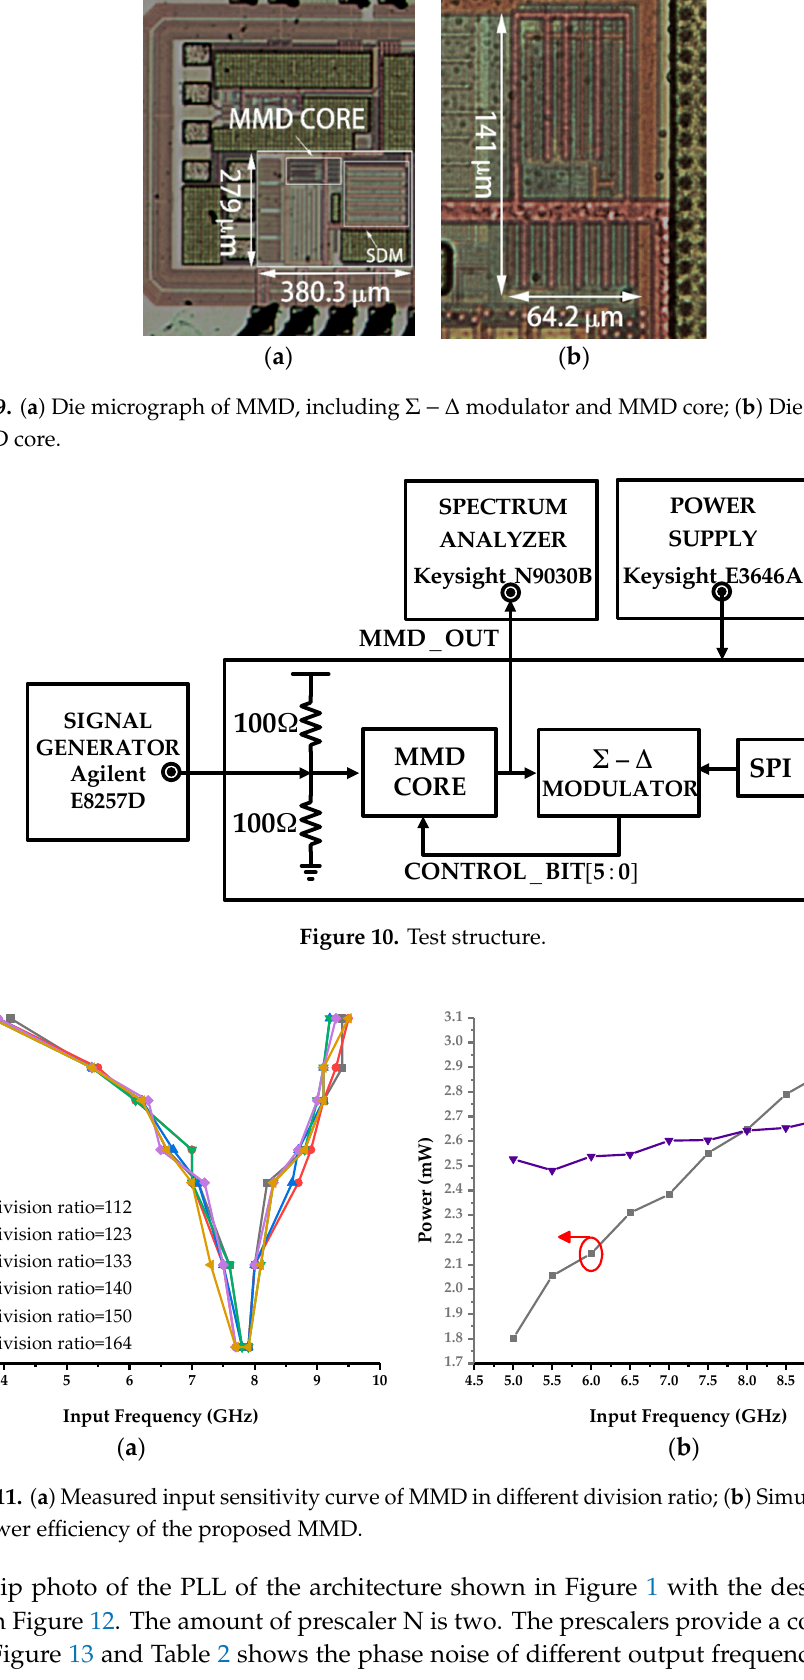
Figure 11. ( a ) Measured input sensitivity curve of MMD in different division ratio; ( b ) Simulated power and power efficiency of the proposed MMD.